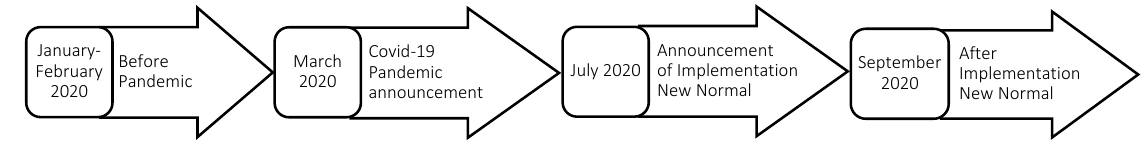
Figure 1. Research timeline